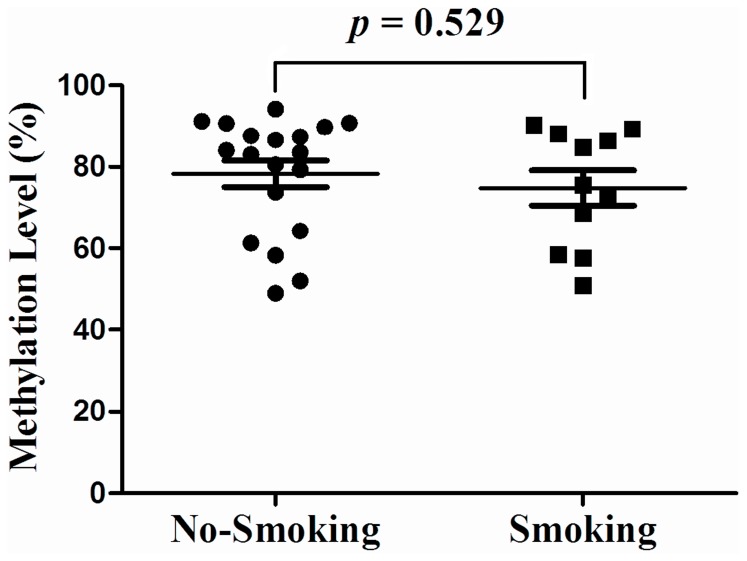
No influence of smoking was found on DRD4 methylation in male SCZ subjects.